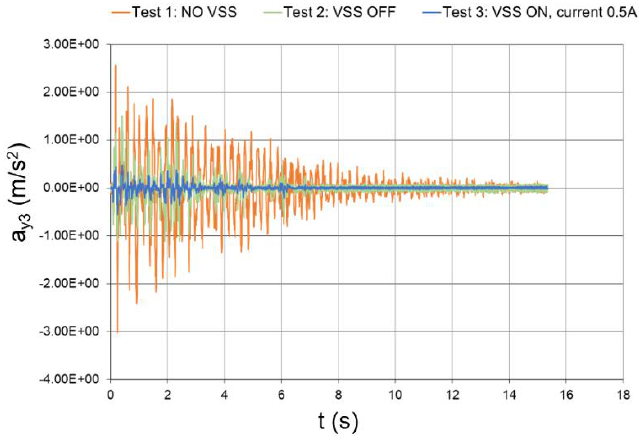
Figure 46. Seismic response, 3rd-floor acceleration with respect to the ground (experimental data).